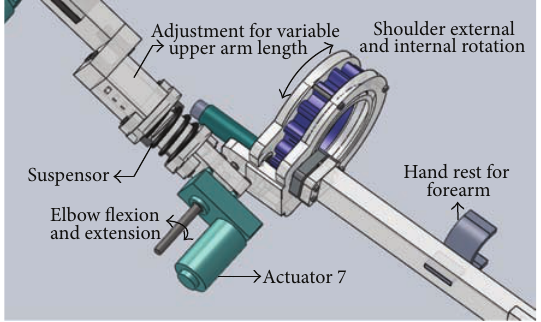
Figure 7: Elbow joint